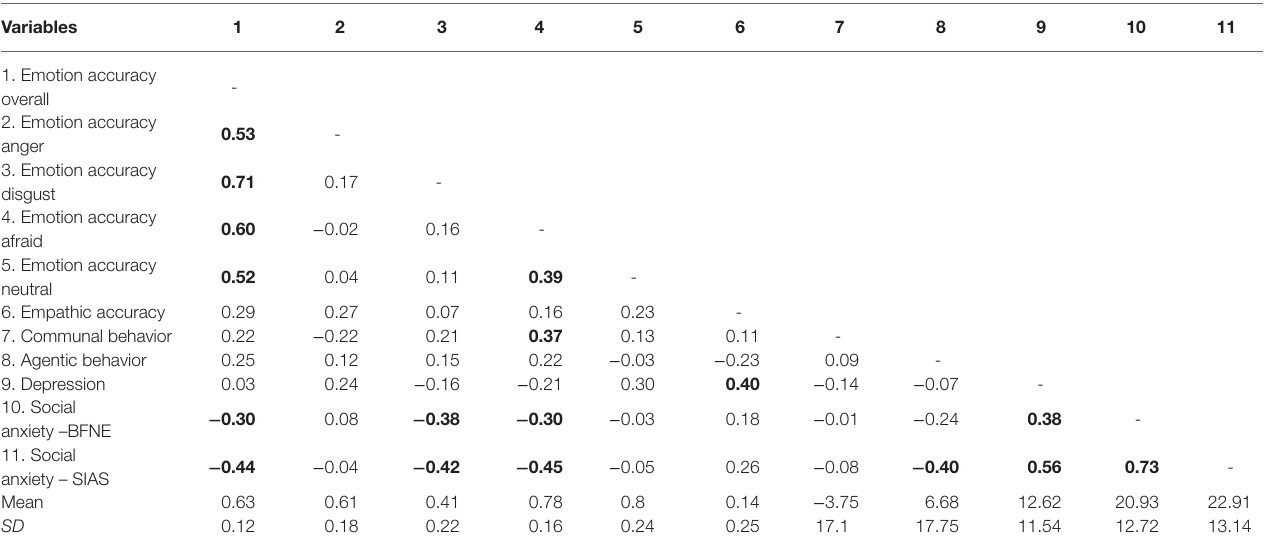
TABLE 2 | Between-person Pearson’s correlations for study variables and descriptive statistics.